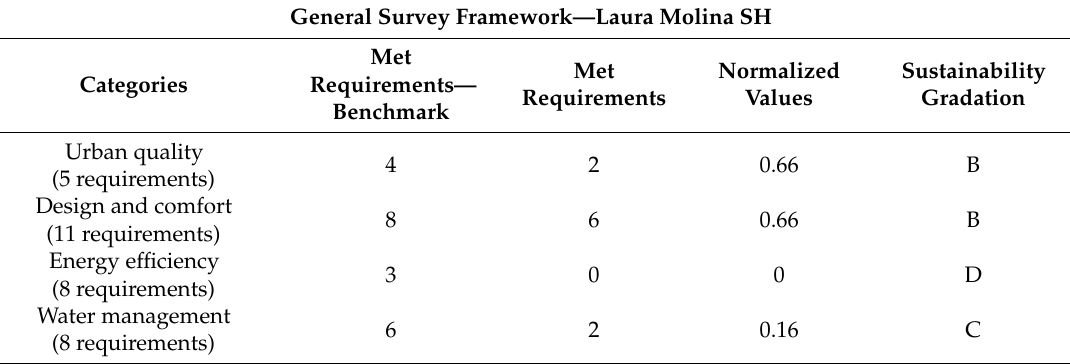
Table 7. Profile of the evaluation of Laura Molina SH using the